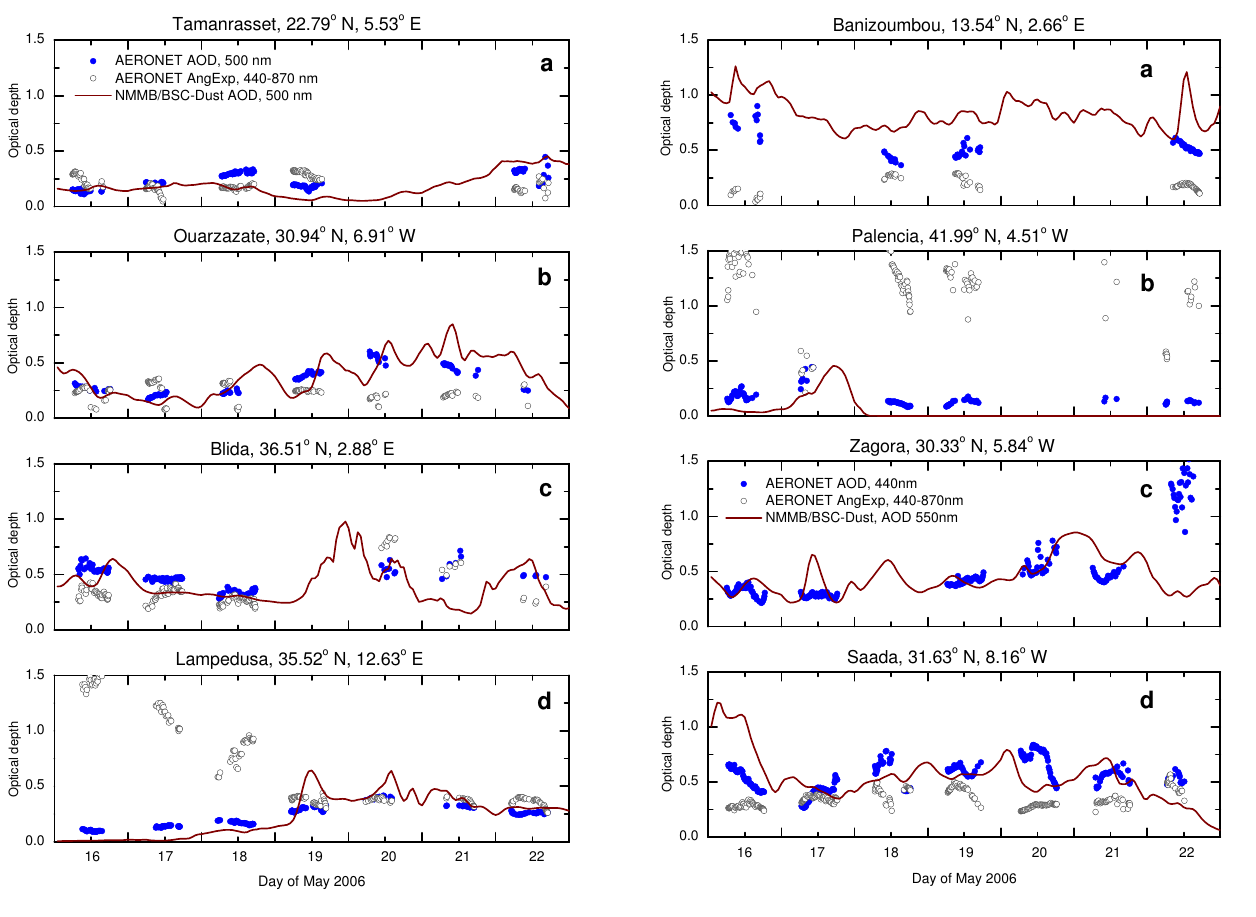
Fig. 8. Model derived AOD (brownish line) versus AERONET AOD (blue dots) and ˚Angstr¨om exponent (black circles) for the pe- riod of 16–22 May at Tamanrasset (a) , Ouarzazate (b) , Blida (c) , and Lampedusa (d) .